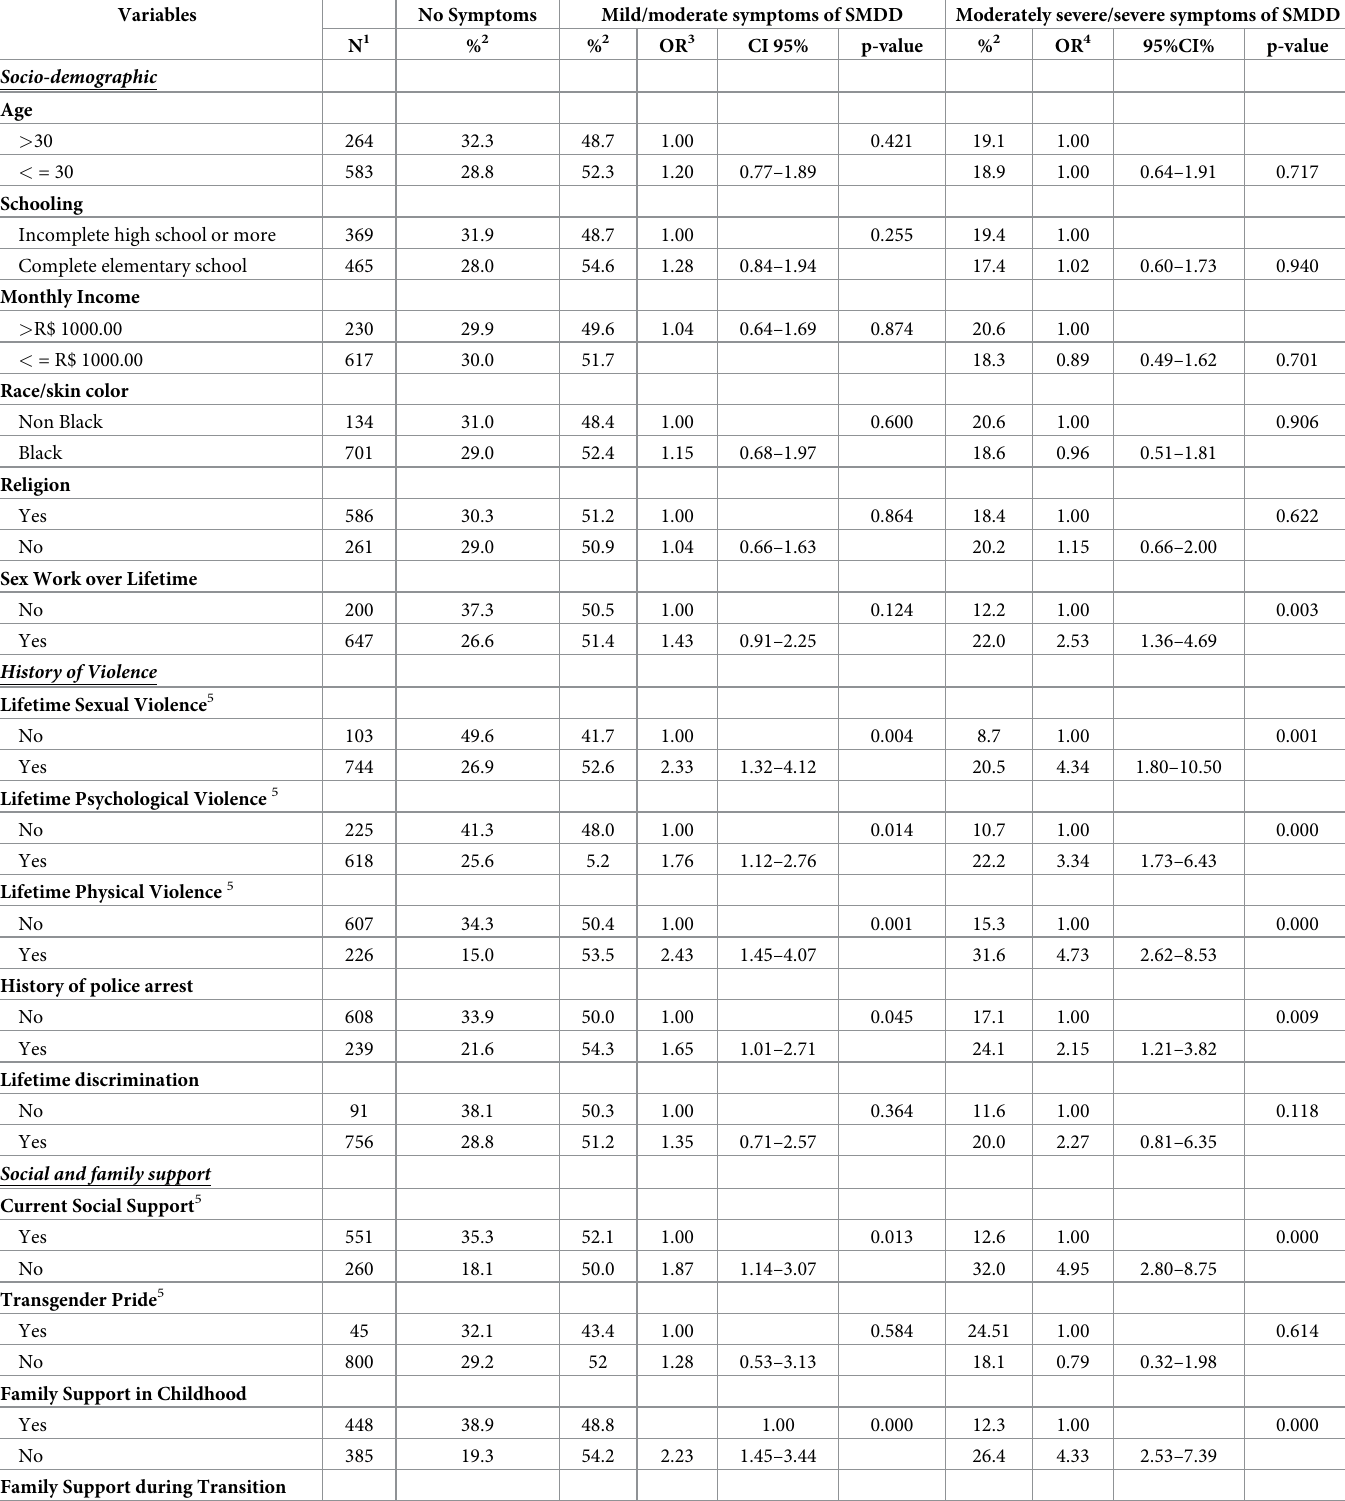
Table 1. Descriptive and bivariate analyses of symptoms of SMDD according to study variables, among transgender women in Northeast Brazil, 2017.